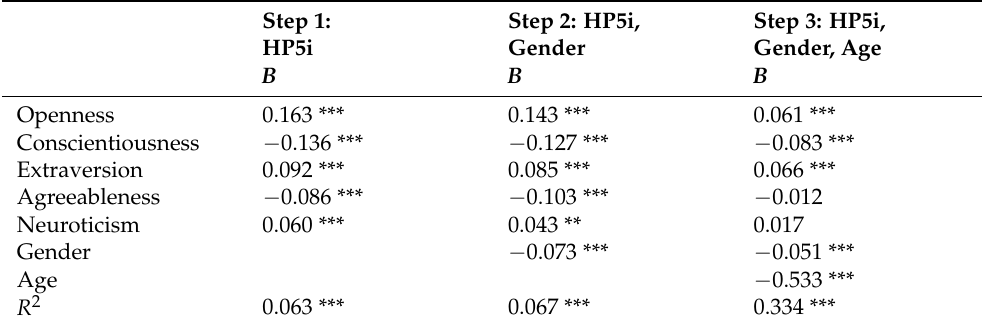
Table 2. Hierarchical regression model exploring how personality factors (HP5i), gender, and age predict social media